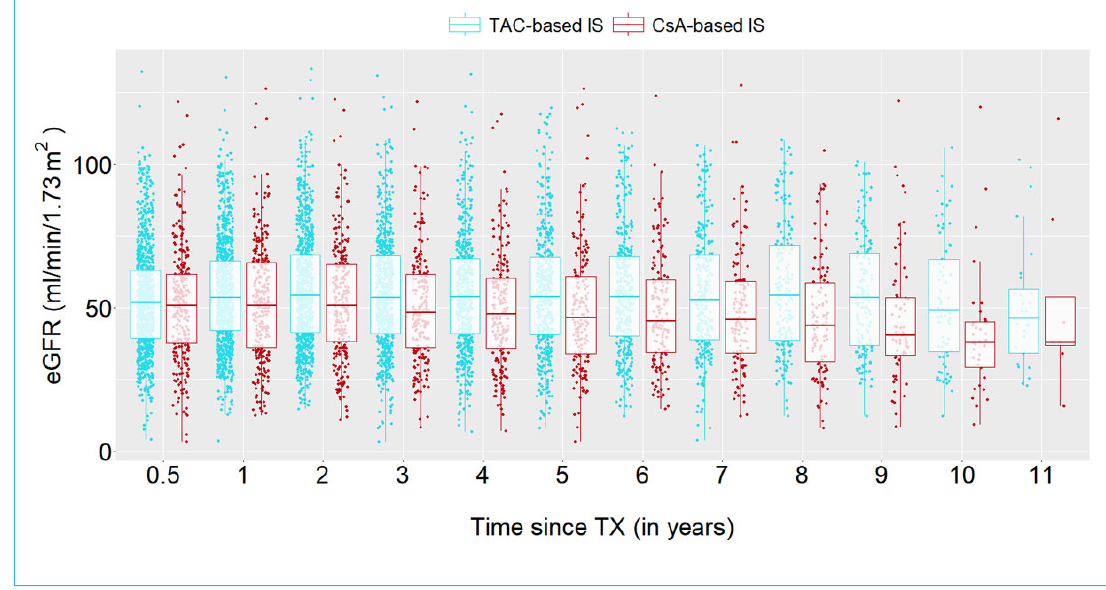
Figure 4: Probability of graft failure post renal transplantation, stratified by immunosuppression therapy.“TAC-based” was defined as the com- bination of prednisone, tacrolimus and mycophenolate mofetil. “CsA-based” corresponds to the combination of ciclosporin, prednisone and mycophenolate mofetil.